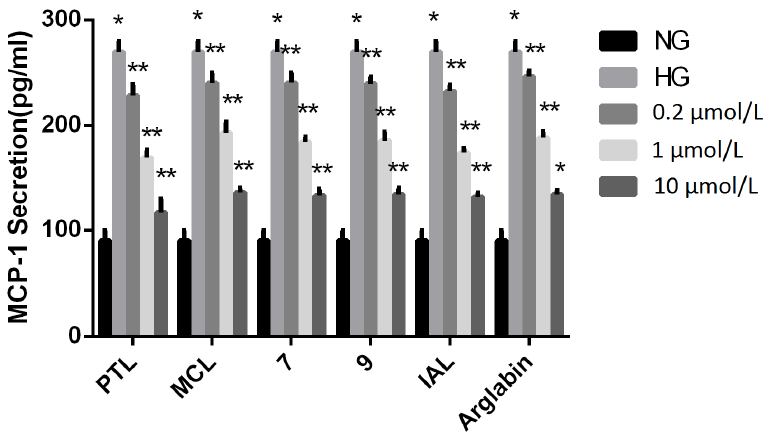
Figure 3. Effect of sesquiterpene lactones on HG-induced regulation of MCP-1, TGF- β 1 and FN in MCs at a concentration of 0.2, 1, 10 μ M. NG: normal glucose; HG: high glucose. * p < 0.05 vs. NG, ** p < 0.05 vs. HG.